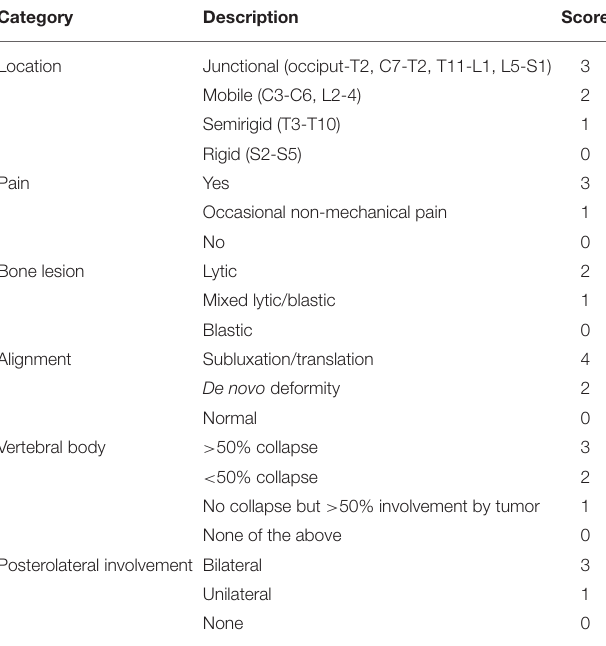
TABLE 2 | Spinal instability neoplastic score